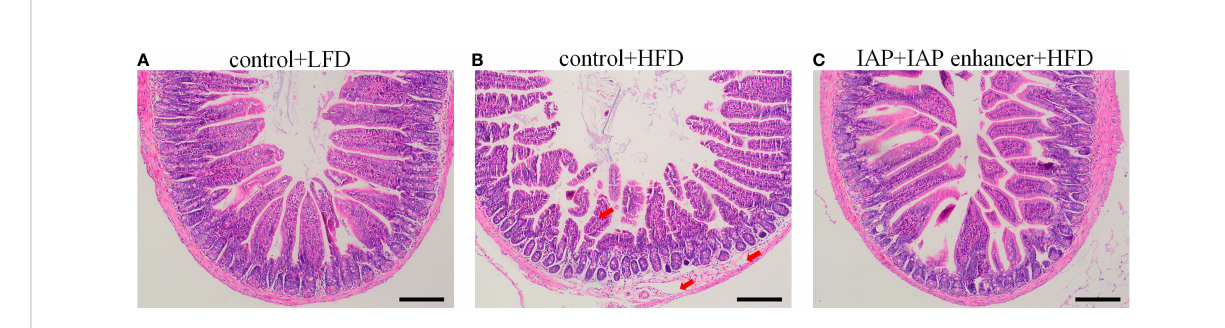
FIGURE 4 Effect of IAP + IAP enhancer treatment on jejunum histopathological alterations (H&E staining, magni fi cation ×100). (A) control + LF group; (B) control + HF group; (C) IAP + IAP enhancer group. The arrows point to the HFD group, and the villi were shortened; the lamina propria was oedematous.